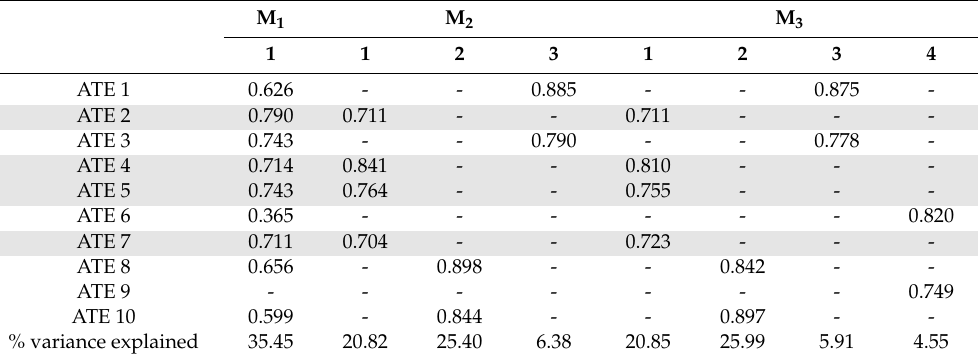
Table 2. Factorial solution for the M1, M2 and M3.